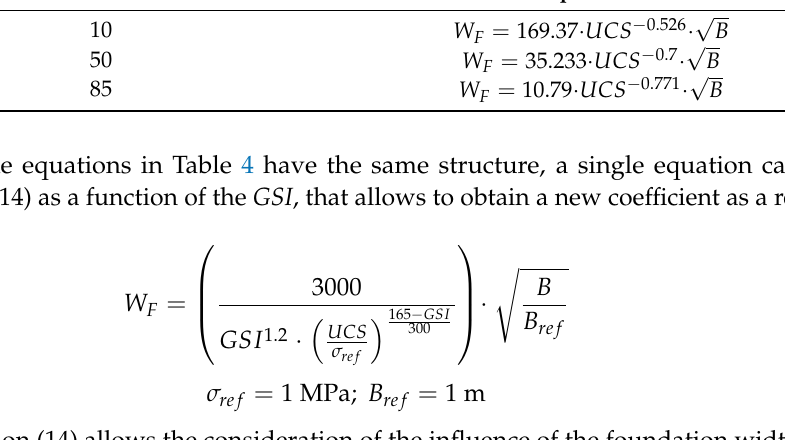
Table 4. W F equations based on UCS for different values of GSI .